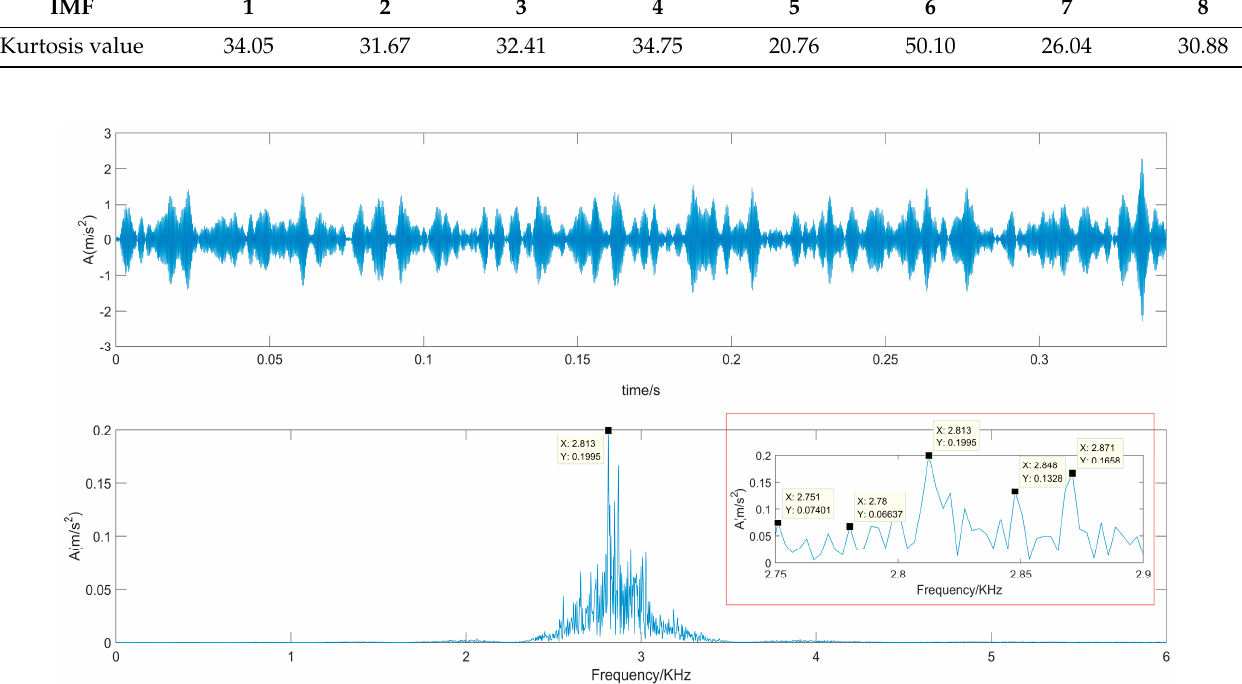
Figure 14. Time-domain waveform and frequency spectrum of the denoised signal using SVD-VMD.